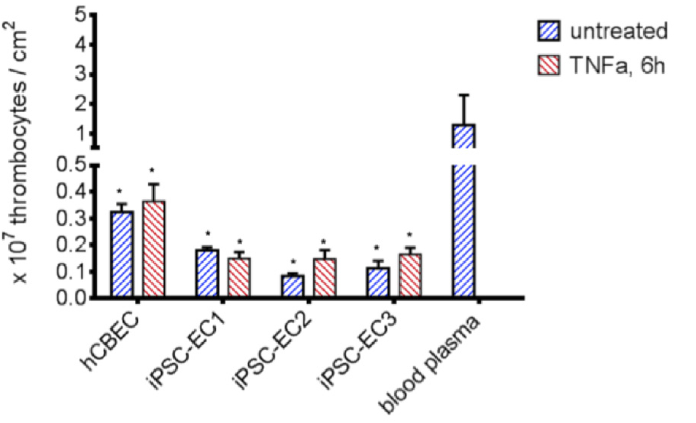
Figure 4. Reduced platelet adhesion to PMP membranes endothelialized with iPSC-ECs. Significantly less thrombocytes adhered to endothelialized samples, compared to blood plasma coated PMP membranes ( p < 0.05). A higher platelet count could be detected when iPSC-EC2, iPSC-EC3 and hCBEC were activated with TNF α for 6 h, while differences were statistically not significant. All data represent the means of independent triplicates for each EC type and treatment. Dunnet’s multiple comparison test, differences to the blood plasma group were considered significant at p < 0.05 (*).